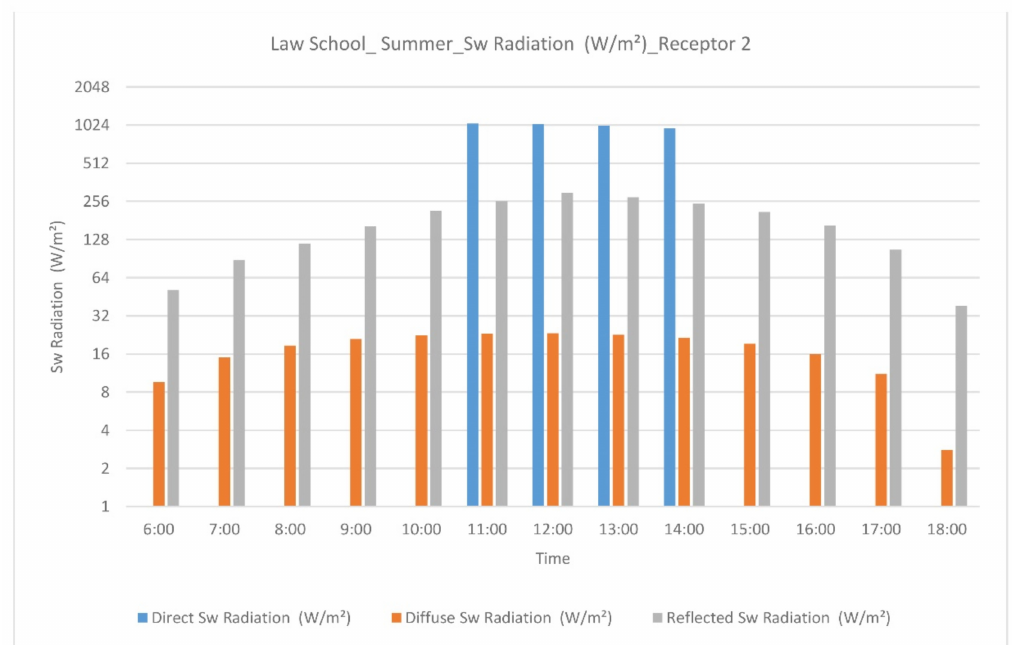
Figure A6. Open space 2 solar radiation in summer at receptor